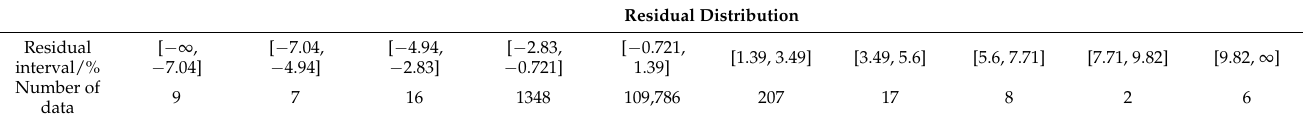
Table 1. Statistics of wavelet transform residual distribution of W f . Residual Distribution